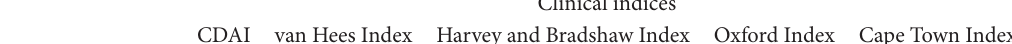
Table 5: Correlations of results for evaluation by clinical indices (Crohn’s Disease Activity Index, van Hees Index, Harvey and Bradshaw Index, Oxford Index, and Cape Town Index) and two endoscopic indices (SES-CD and CDEIS) for patients with Crohn’s disease and control group (correlation was made between the five mentioned clinical indices and the most representative endoscopic segment). The same five clinical indices were correlated with histological index (Scoring System for Histological Disease Activity in Crohn’s Disease) (correlation was made between the five mentioned clinical indices and the most representative section in the histological index).